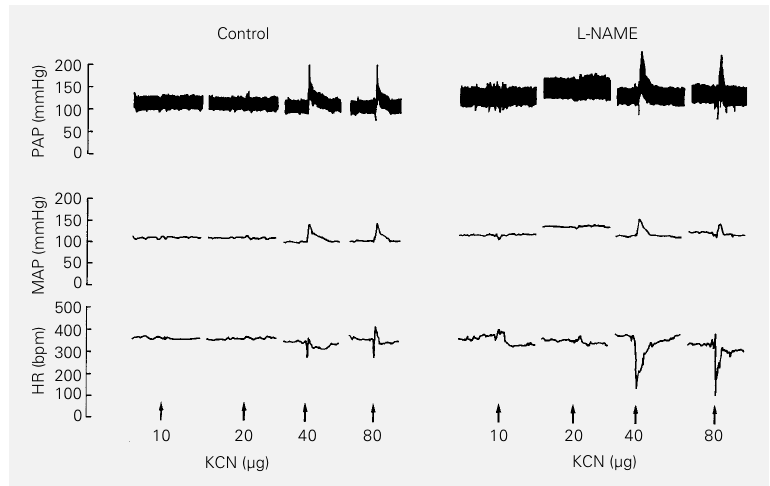
Figure 8 - Typical recording showing the KCN-induced chemoreflex comparing the changes in pulsatile (PAP) and mean (MAP) arterial pressure and heart rate (HR) in a rat treated